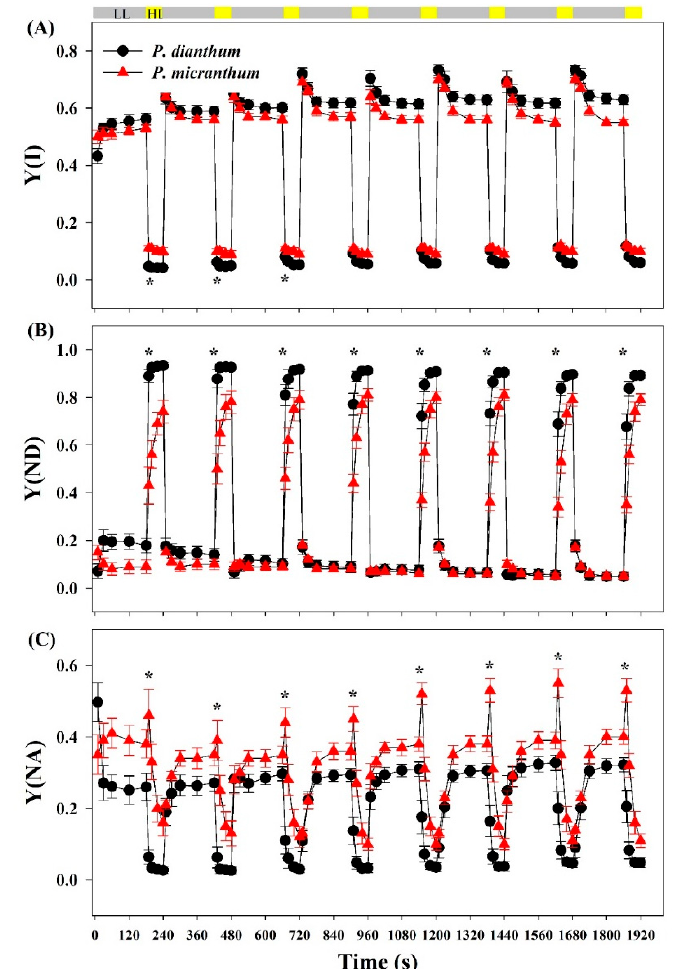
Figure 1. PSI parameters of Paphiopedilum dianthum and P. micranthum under fluctuating light. Y(I), effective quantum yield of PSI ( A ); Y(ND), PSI donor side limitation ( B ); Y(NA), PSI accept side limitation ( C ). Each data point represents the mean ± SE for five measurements from five individual plants. LL, low light; HL, high light. Asterisks indicate significant differences between P. dianthum and P. micranthum with the t -tests of independent